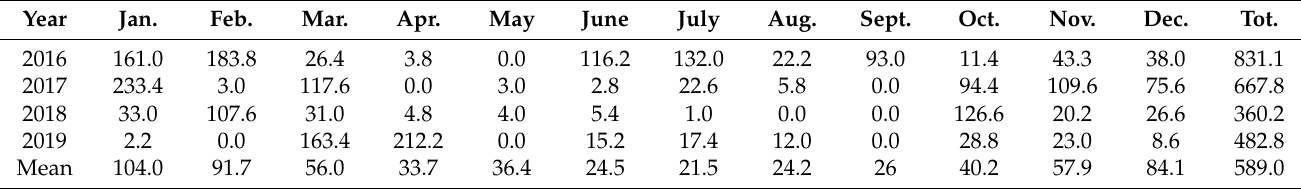
Table 2. Monthly and annual precipitation at the Willows township from 2016–2019 and the long-term mean for each month and